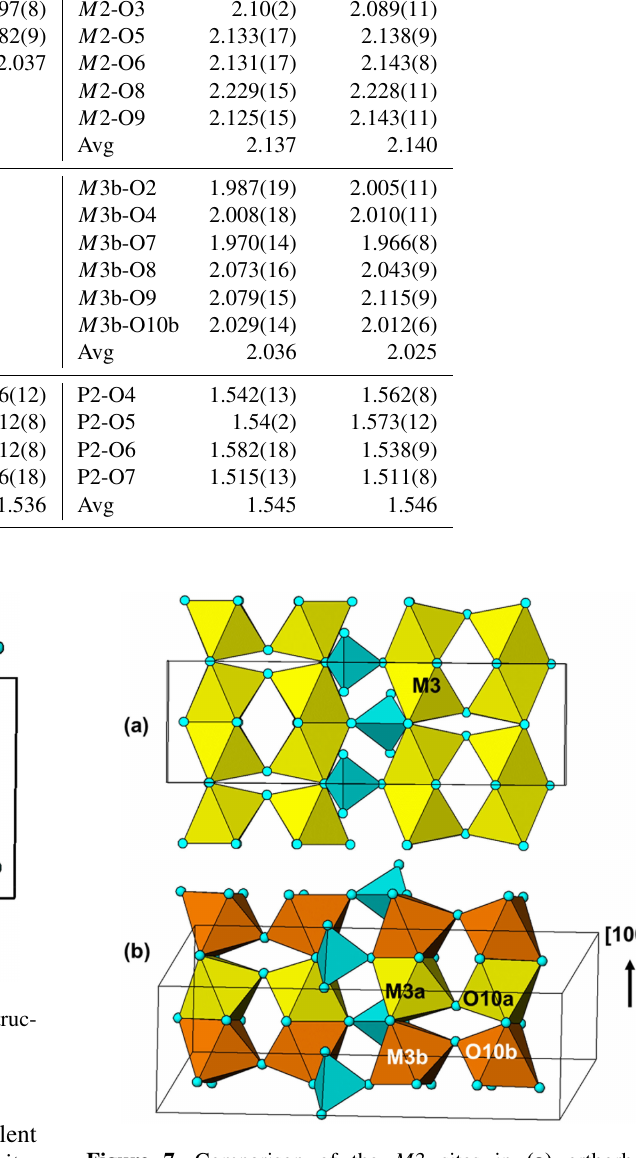
measured compositions, marked with crosses, are from Grey et al. (2019a,